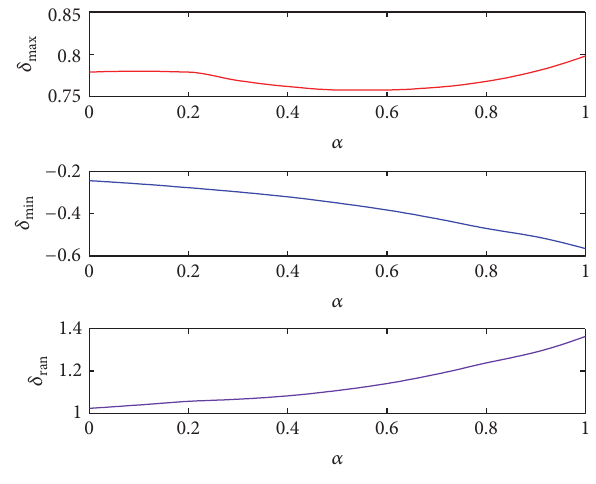
Figure 5: The curves of 𝛿 max , 𝛿 min , and 𝛿 ran along with 𝛼 . Table 4: The allowable range 𝛿 ran for different pair ( 𝜖 1 , 𝜖 2 ).